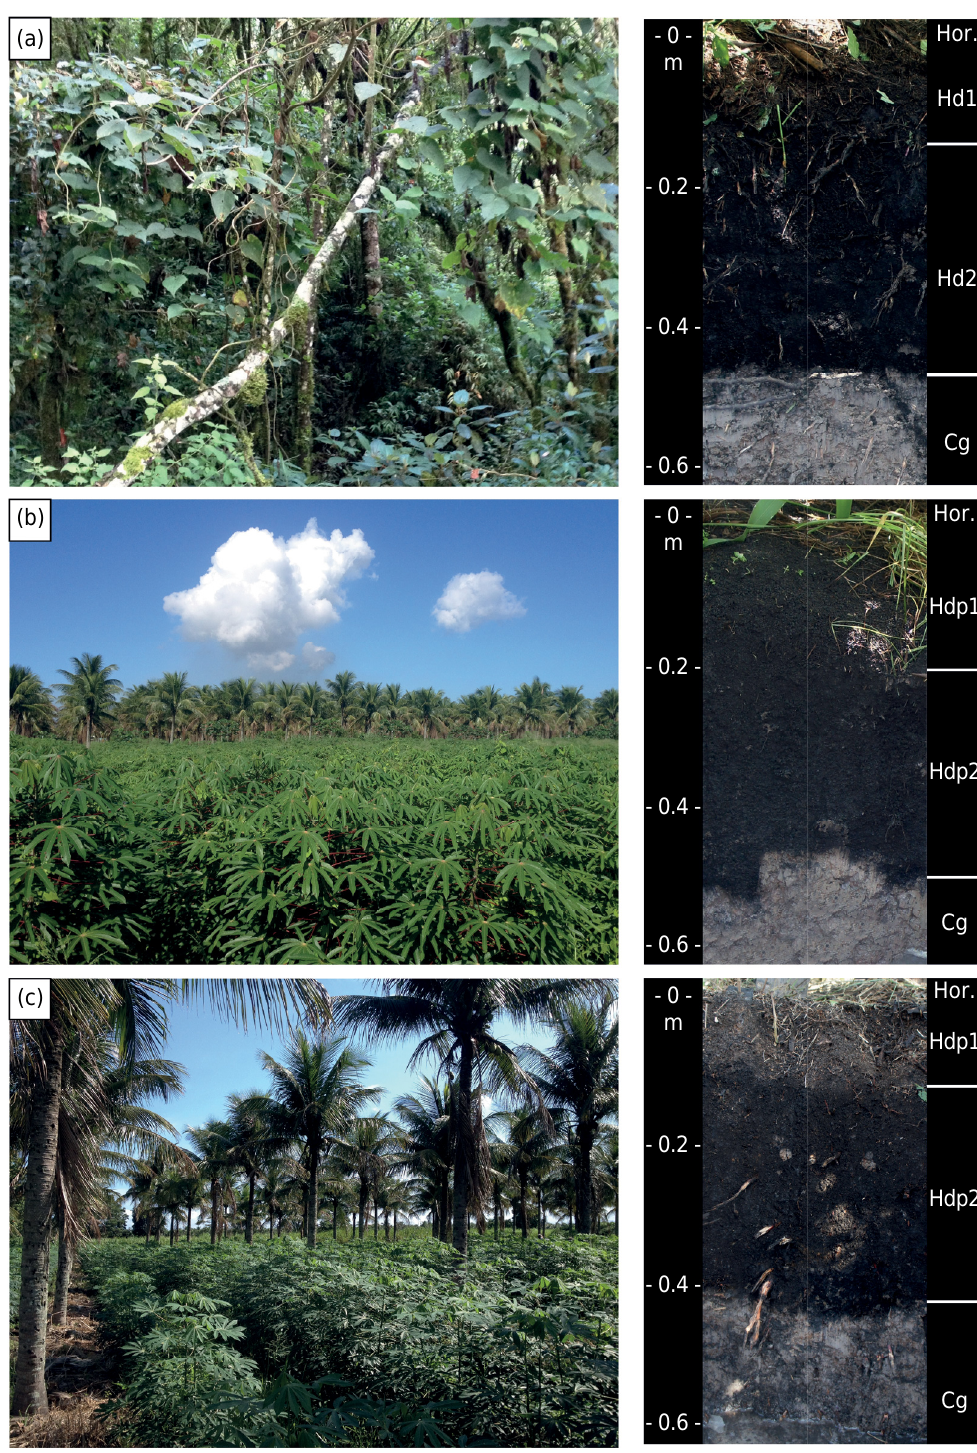
Figure 2. Histosol profiles under different land use systems in the municipality of Rio de Janeiro, Brazil. Secondary tropical forest (natural vegetation) (a); conventional tillage of cassava ( Manihot esculenta ) (b); and intercropped coconut ( Cocos nucifera ) with cassava ( Manihot esculenta )